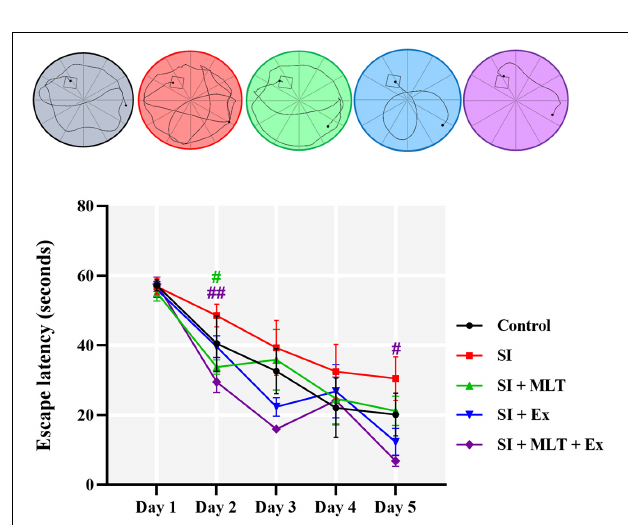
in anxiety index in SI + MLT + Ex compared with and SI + Ex ( P = 0.7686).